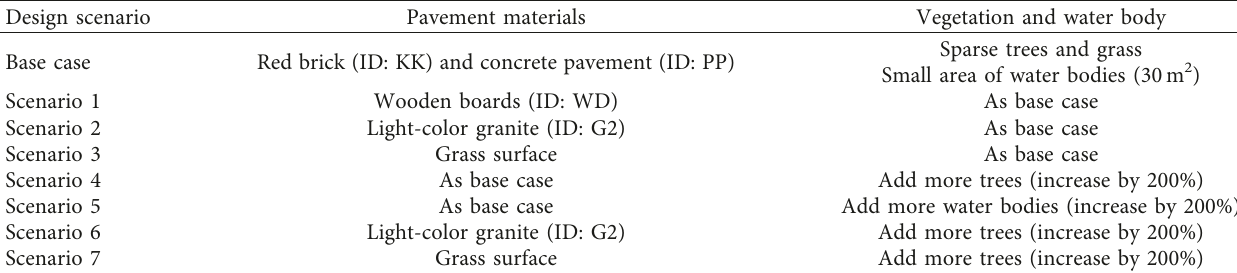
Table 3: Different design scenarios for Bedok.